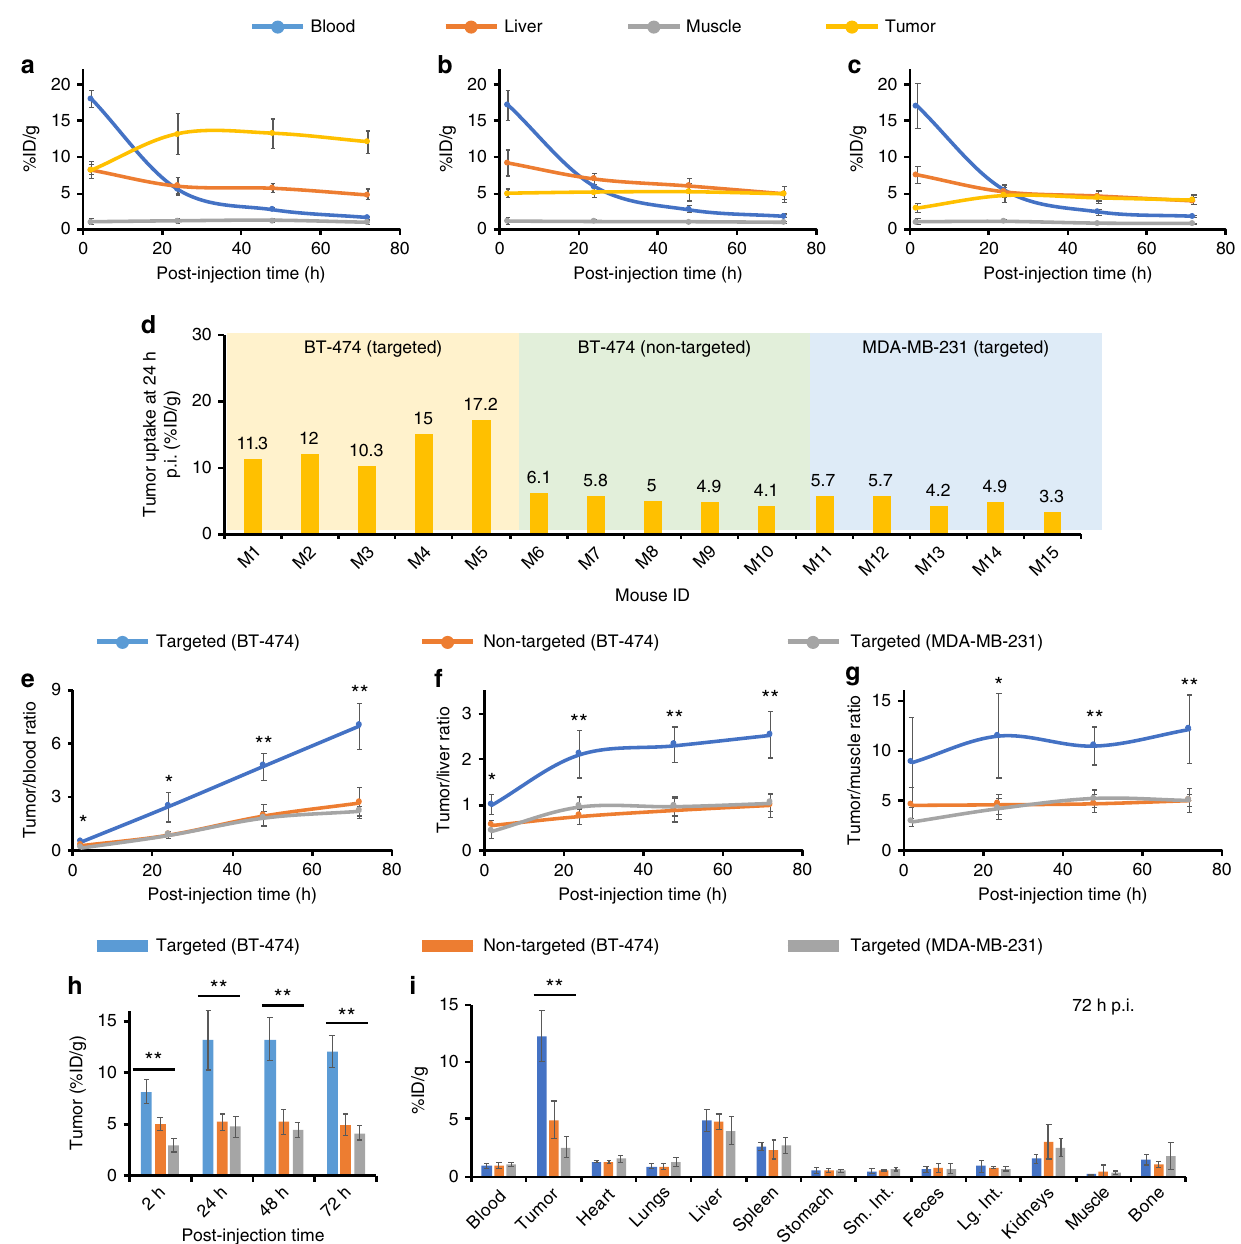
Fig. 4 Region-of-interest quanti fi cation and biodistribution studies. Time – activity curves showing major organ uptake of 89 Zr-labeled nanoparticles in mice injected with a targeted group: 89 Zr-DFO-scFv-PEG-Cy5-C ’ dots, BT-474 tumor, b non-targeted group: 89 Zr-DFO-Ctr/scFv-PEG-Cy5-C ’ dots, BT-474 tumor, and c targeted group: 89 Zr-DFO-scFv-PEG-Cy5-C ’ dots, MDA-MB-231 tumor. d Variation of tumor uptake (%ID g − 1 ) for 3 cohorts of mice. M1 – M5: BT-474 tumor-bearing mice injected with 89 Zr-DFO-scFv-PEG-Cy5-C ’ dots (targeted); M6 – M10: BT-474 tumor-bearing mice injected with 89 Zr-DFO-Ctr/ scFv-PEG-Cy5-C ’ dots (non-targeted); M10 – M15: MDA-MB-231 tumor-bearing mice injected with 89 Zr-DFO-scFv-PEG-Cy5-C ’ dots (targeted). Comparisons of e tumor-to-blood ratios, f tumor-to-liver ratios, g tumor-to-muscle ratios, and h tumor uptake among three groups. N = 5 animals per group. i Biodistribution pro fi les for all animal group at 72 h p.i. * p < 0.01, ** p < 0.001. The two degrees-of-freedom F -test was followed by pairwise t -tests that were adjusted for multiple comparisons using the Holm method. Each data point represents the mean ± s.d. of fi ve